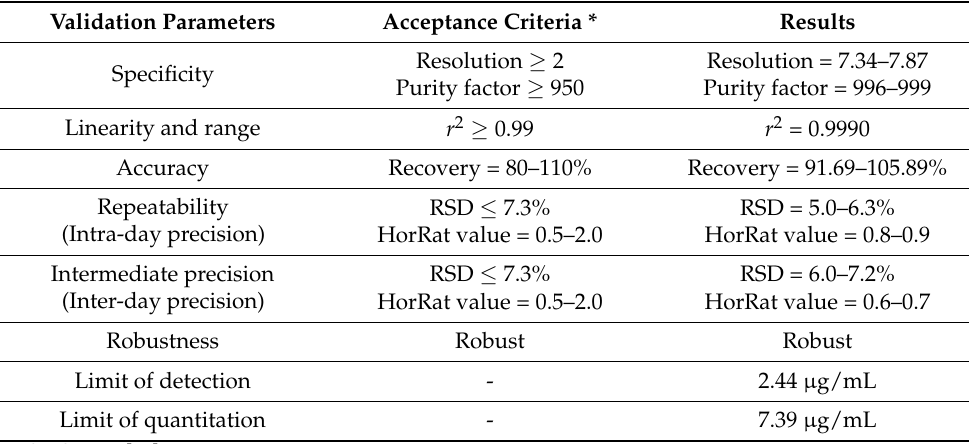
Table 5. Summary of analytical method